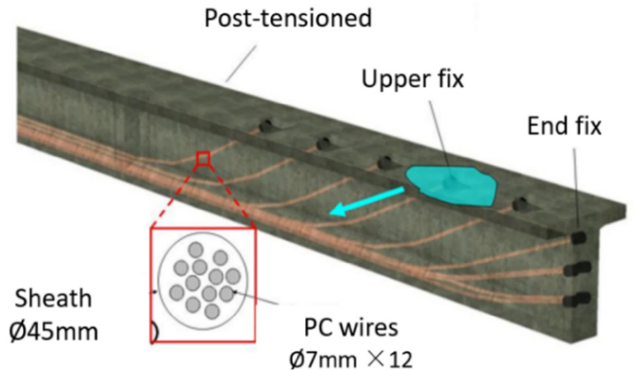
Figure 5. Reinforcement distribution within a structure.